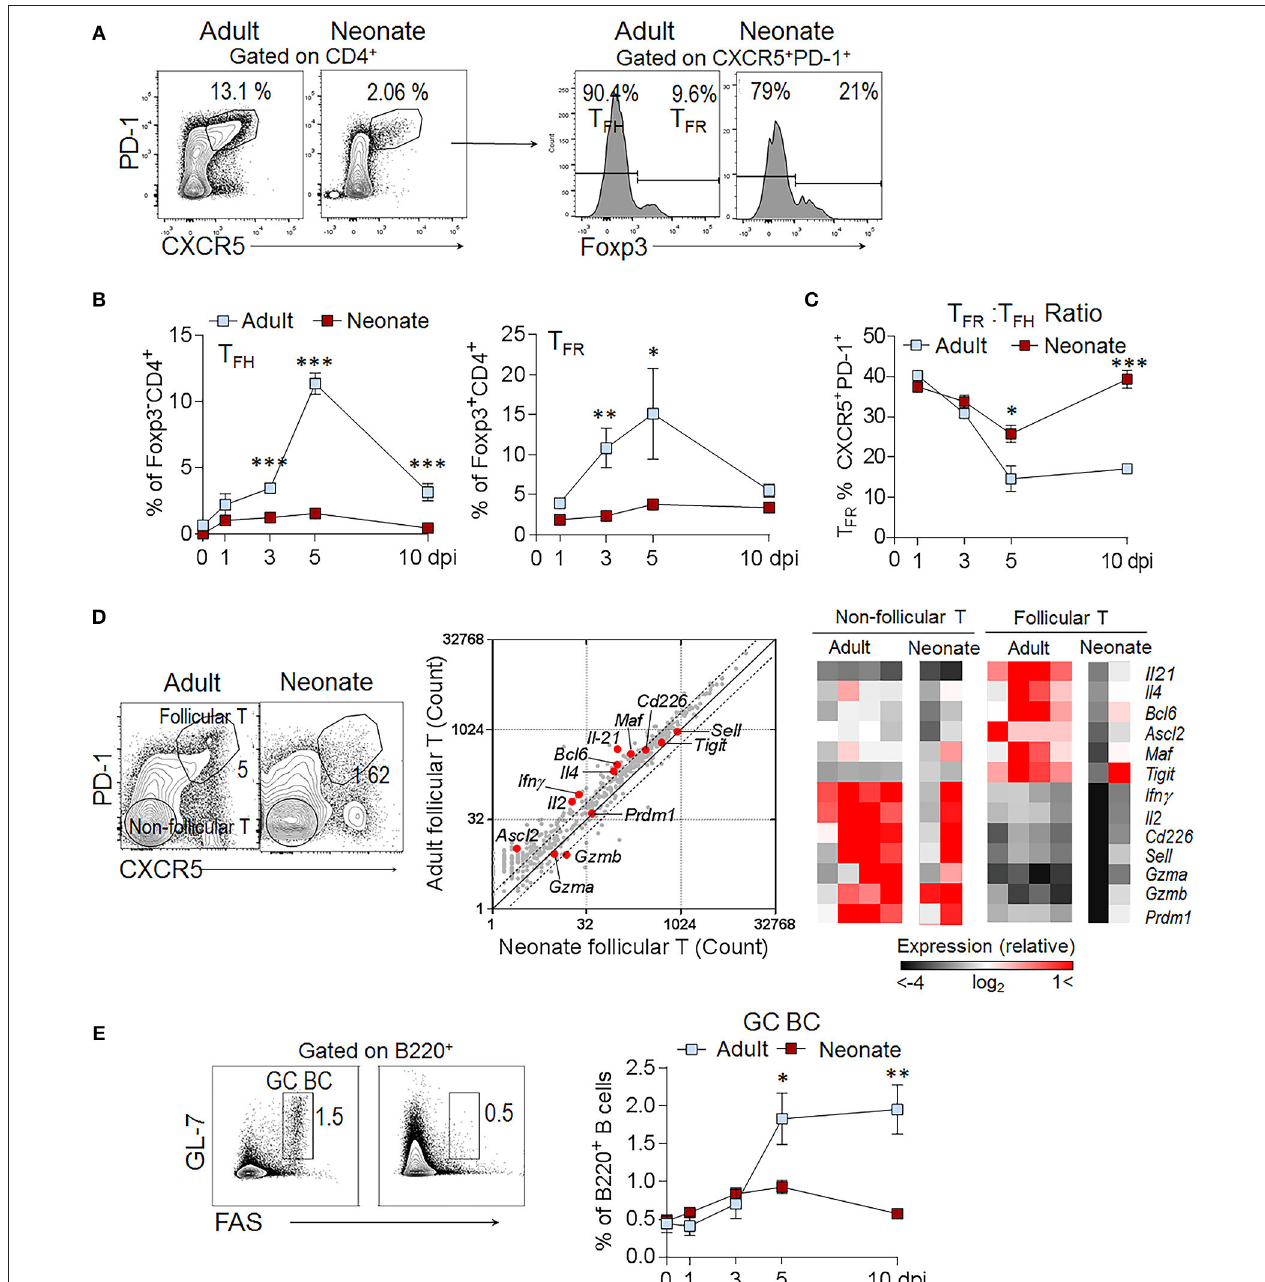
FIGURE 1 | High T FR : T FH ratio persists throughout the immune response in immunized neonatal mice. Adult (6- to 10-week-old) and neonatal (5 day-old) mice were immunized i.p. with SRBC. Kinetics of splenic T FH and T FR cell generation was assessed in flow cytometry. (A) Representative dot plots depict the percentage of T FH (CD4 + CXCR5 + PD-1 + Foxp3 − ) and T FR (CD4 + CXCR5 + PD-1 + Foxp3 + ) cells pre-gated on CD4 + cells at 5 dpi. (B) Mean percentage of T FH cells among Foxp3 − CD4 + and T FR cells among Foxp3 + CD4 + cells are plotted ( n = 4). (C) The ratio of T FR to T FH cells (T FR : T FH ) are plotted ( n = 4). (D) Analysis of gene expression profile in sorted follicular and non-follicular T cell populations. Flow cytometry gating strategies for follicular (CD4 + CXCR5 + PD-1 + ) and non-follicular (CD4 + CXCR5 − PD-1 − ) T cells are shown at 10 dpi. Expression of 547 immunology-related genes in neonatal vs. adult follicular T cells (gray) is plotted. Each plot displays average mRNA gene-counts and fold change. The dashed lines represent a 2-fold change. Heat maps represent the relative expression of T FH associated genes. Red represents relatively high expression, whereas black represents relatively low expression. Each column represents one replicate pooled from three adult or eight neonatal mice. (E) Representative dot plots depict the GC (GL-7 + FAS + ) cells pre-gated on B220 + cells at 7 dpi. Mean percentages of GC B cells are plotted ( n = 4). One out of three experiments with similar results is shown. Error bar, s.e.m.. * p < 0.05, ** p < 0.01, *** p < 0.001 depict comparisons between adult and neonatal mice.